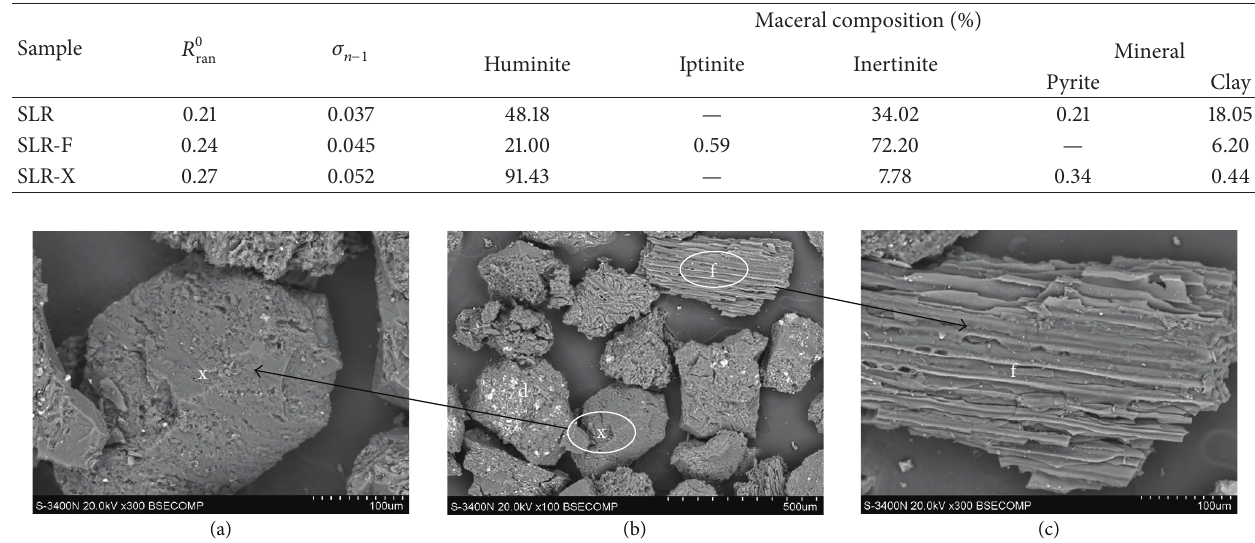
Figure 2: (a) SEM image of xyloid coal (x) (scale = 100 𝜇 m), (b) SEM image of detrital coal (d), xyloid coal (x), and fusinitic coal (f) (scale = 500 𝜇 m), and (c) SEM image of fusinitic coal (f) (scale = 100 𝜇 m).